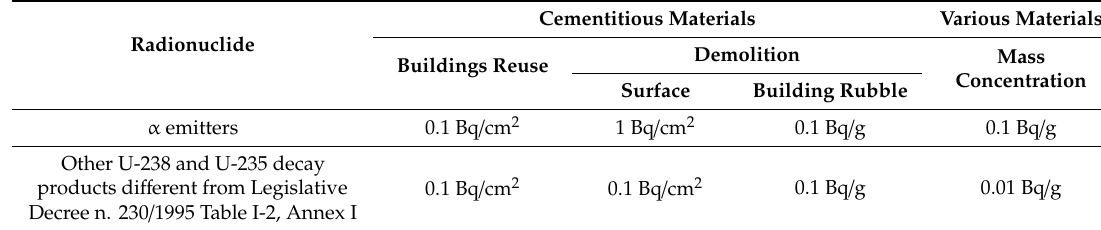
Table 3. Non-metallic materials clearance levels.